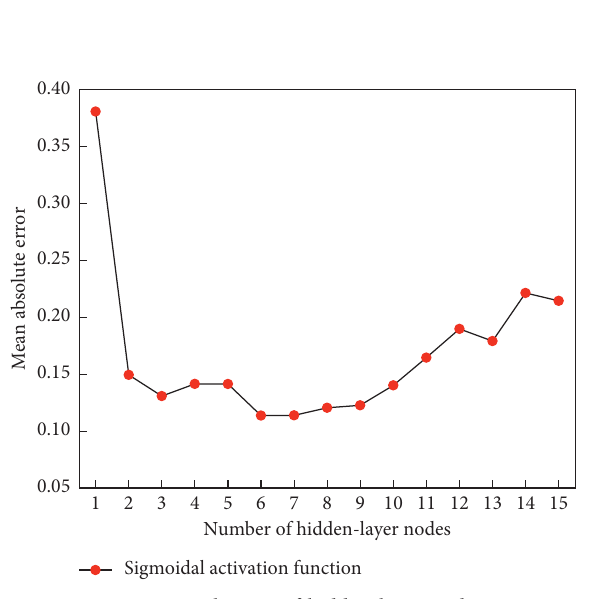
Figure 5: Selection of hidden-layer nodes.